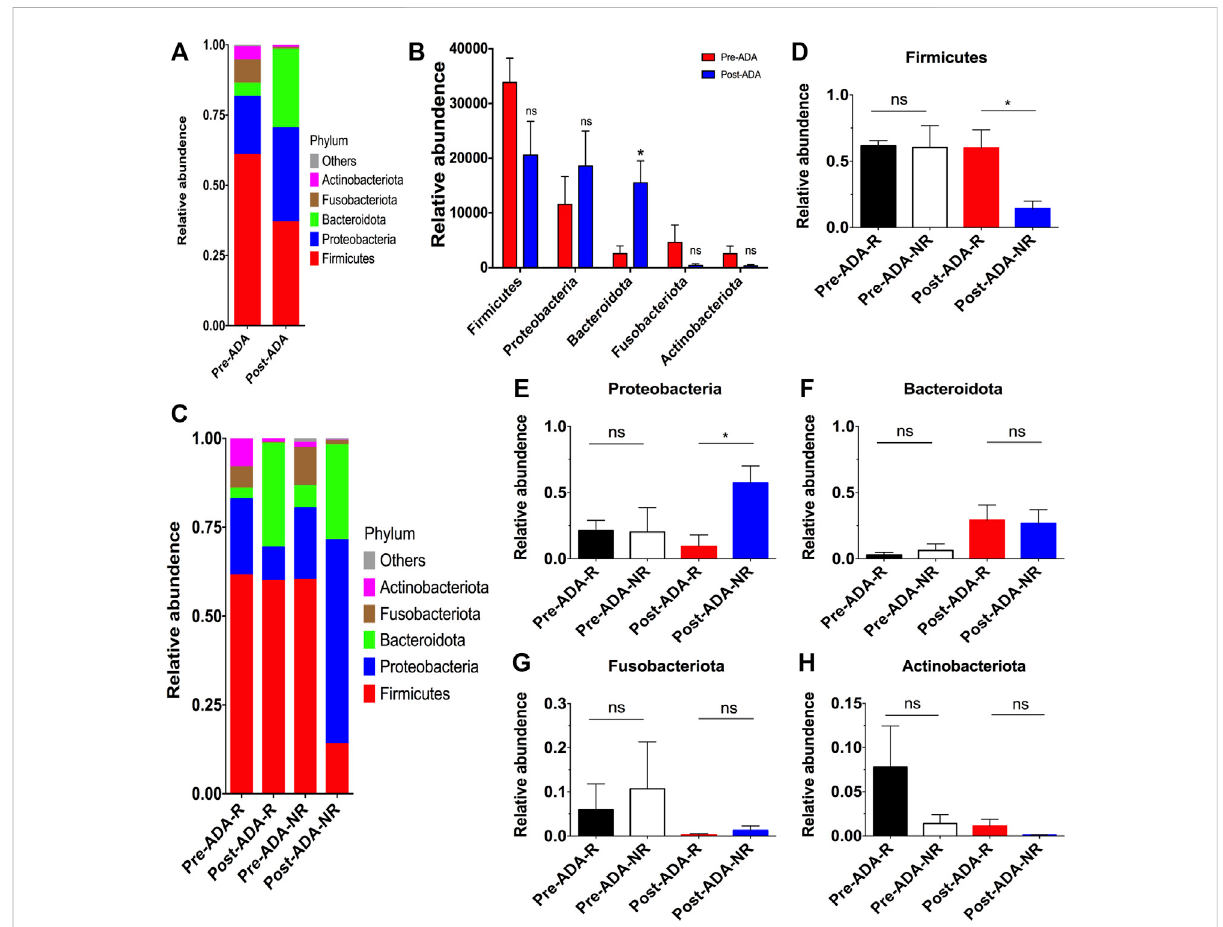
FIGURE 4 Taxonomic differences in the fecal microbiota of patients with CD between different subgroups during ADA therapy. Relative proportions of bacterial phyla were compared between pre-ADA and post-ADA (A) , and statistically analyzed among typical phyla (B) . Meanwhile, the relative abundance of bacterial phyla was also compared in between Pre-ADA-R, Post-ADA-R, Pre-ADA-NR, and Post-ADA-NR (C) . (D) Firmicutes, (E) Proteobacteria, (F) Bacteroidetes, (G) Fusobacteriota, and (H) Actinobacteriota; * p < 0.05; ns, not signi fi cant. Pre-ADA-R, responsive pre- adalimumab samples; Post-ADA-R, responsive post-adalimumab samples Pre-ADA-NR, nonresponsive pre-adalimumab samples; Post-ADA-NR, nonresponsive post-adalimumab